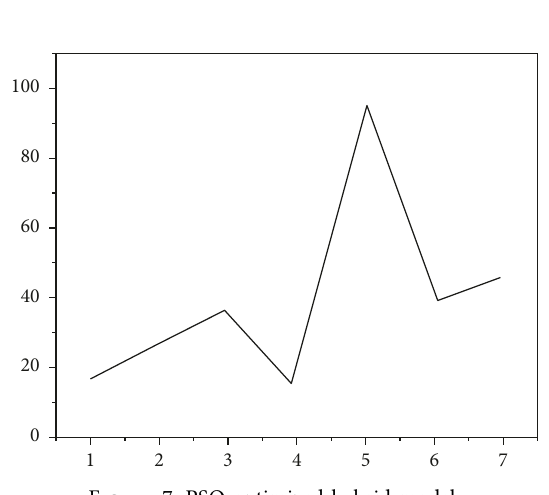
Figure 6: PSO model.